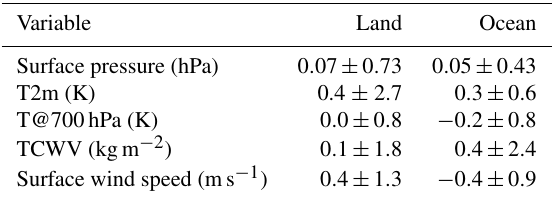
Table 5. Median ± 1 σ of GEOS5 FP-IT–ECMWF differences for GOSAT soundings passing the ABP cloud